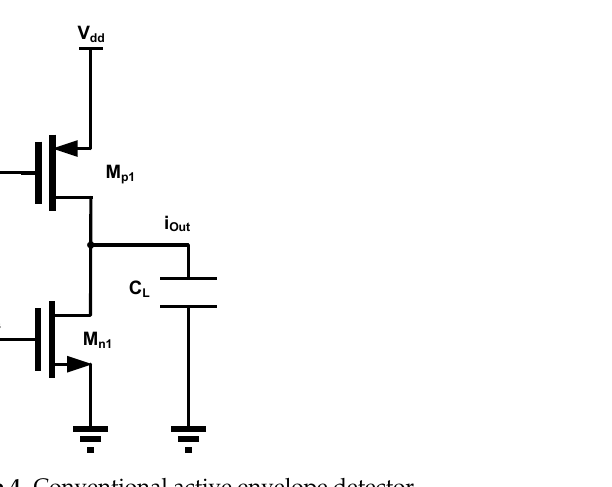
Figure 4. Conventional active envelope detector.